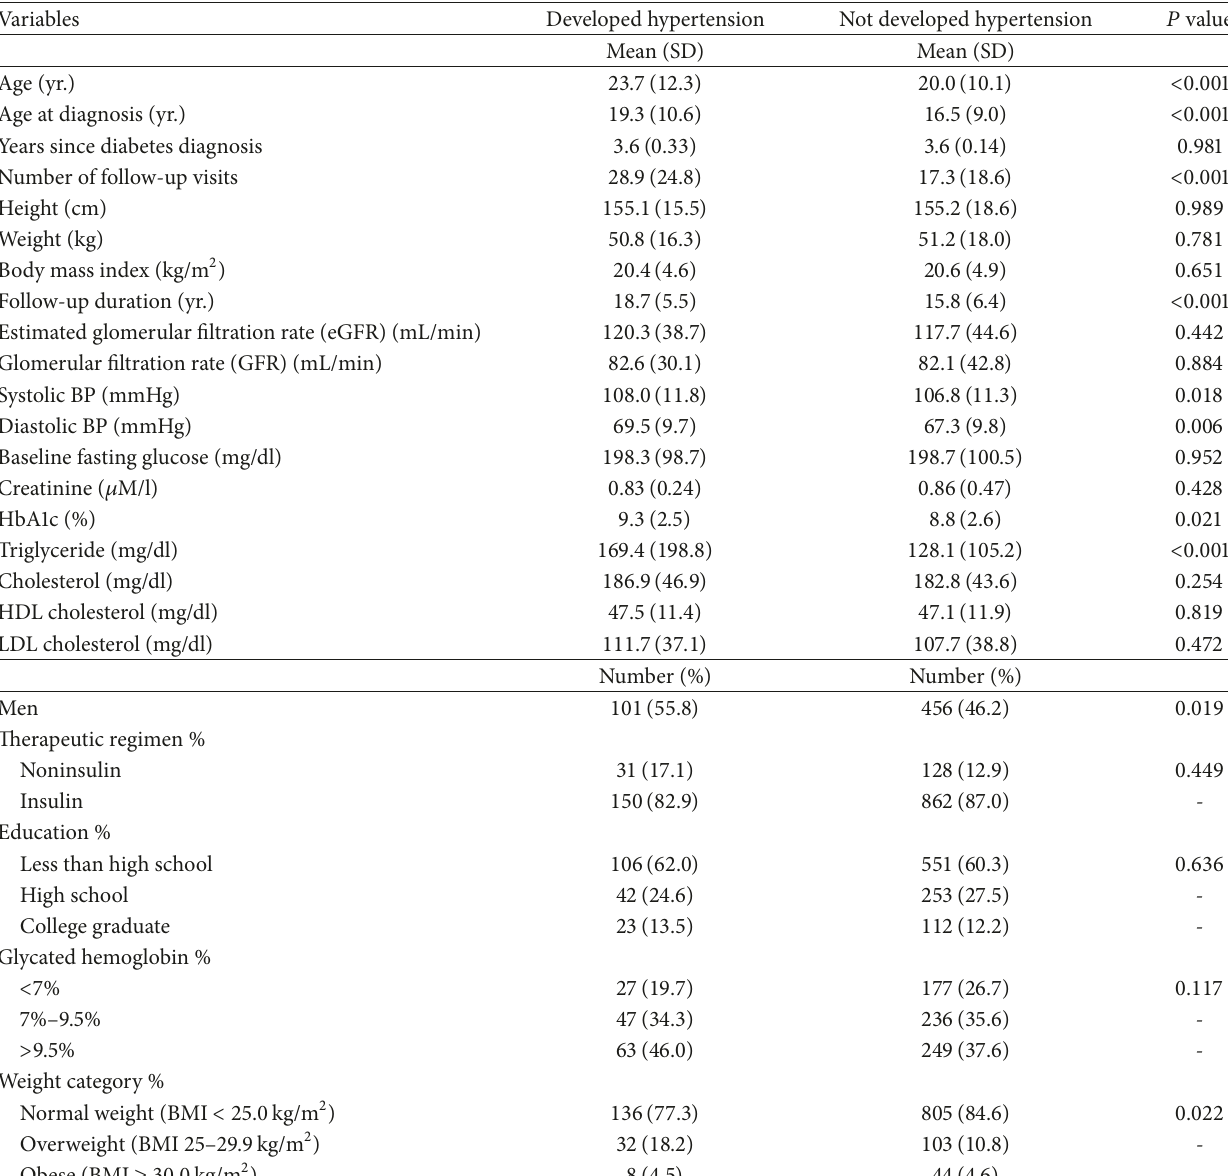
Table 1: Age and age-adjusted means (SD) and proportions of selected baseline characteristics in 181 type 1 diabetes patients who did and 986 who did not develop hypertension at